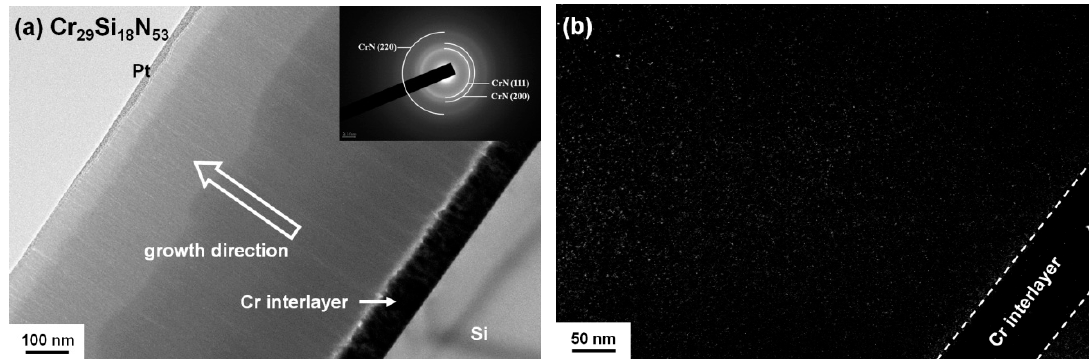
Figure 4. ( a ) Cross-sectional TEM image and selected-area diffraction pattern (SADP) of the Cr 32 Si 14 N 54 coating; ( b ) the dark field image correlated with the diffraction ring of CrN (200) in the SADP.